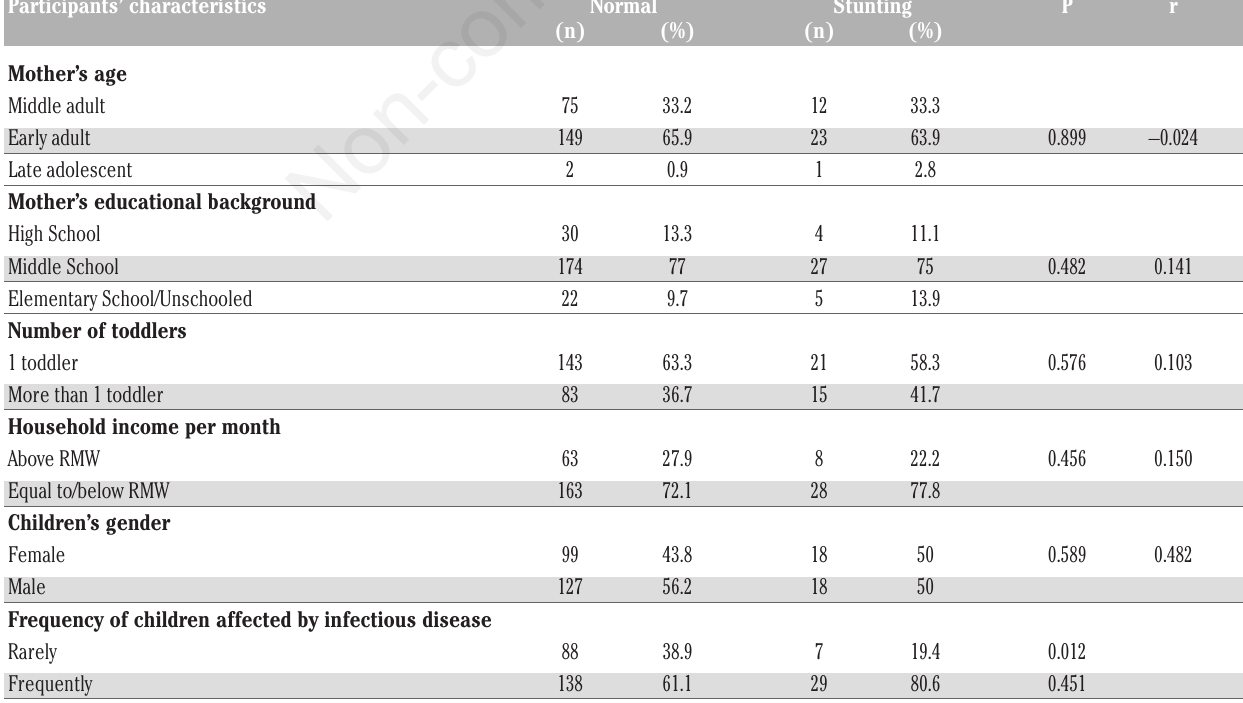
Table 4. Description of association between maternal and children’s characteristics and stunting incidence in